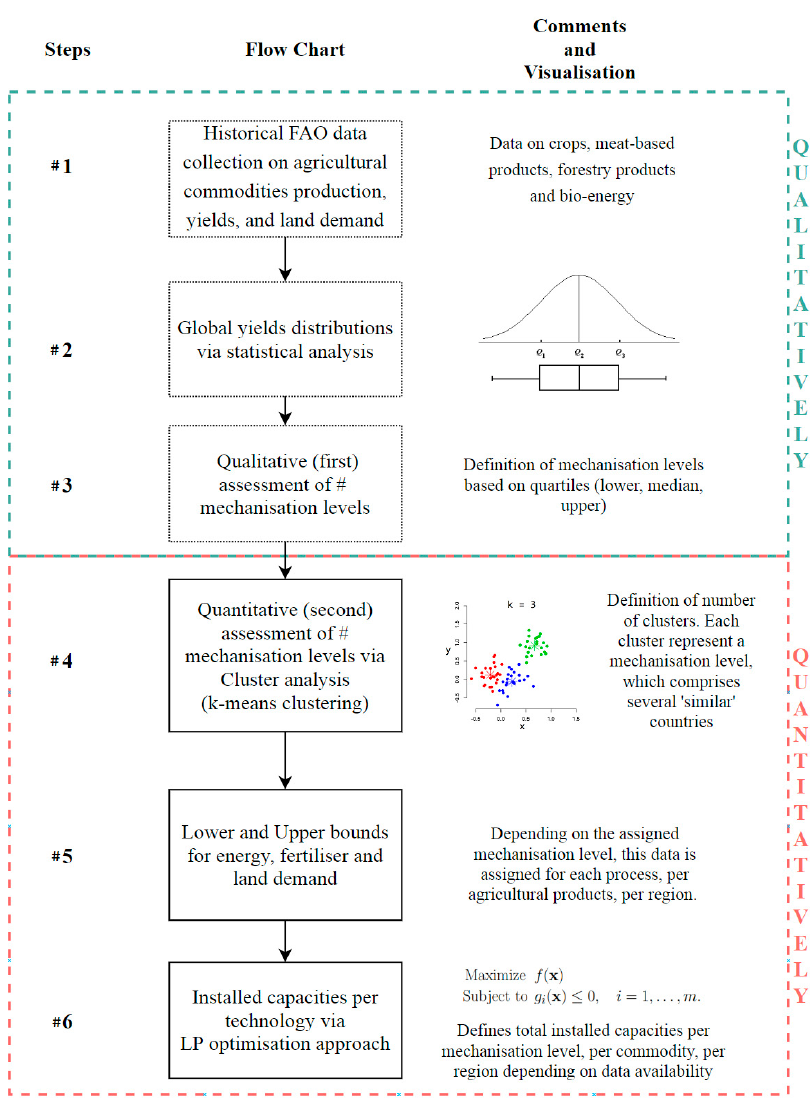
Figure A1. Framework to characterise agricultural processes based on qualitative and quantitative